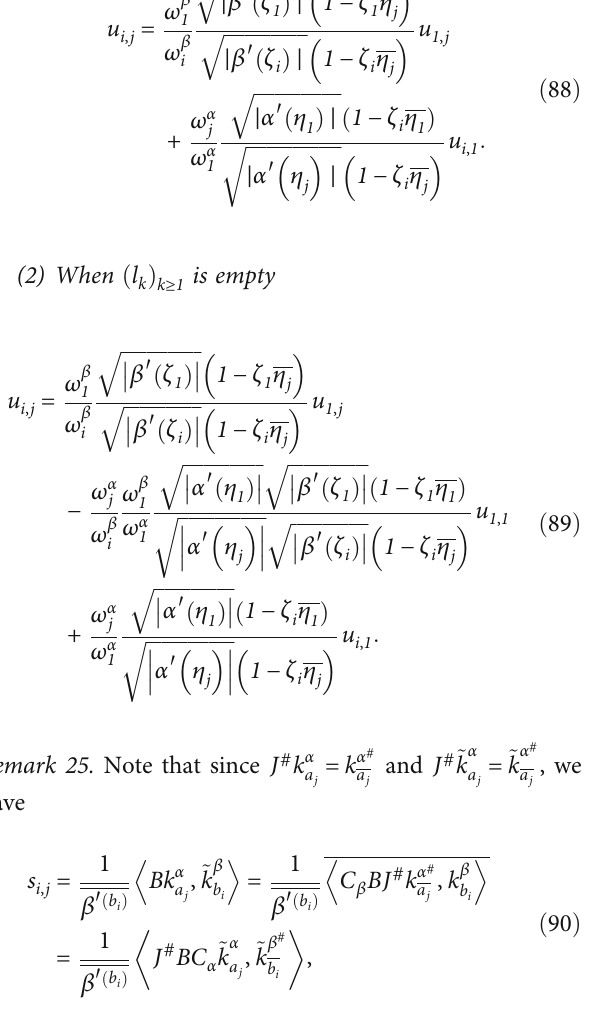
ffiffiffiffiffiffiffiffiffiffiffiffiffiffiffiffi (cid:12) β ′ ζ ð Þ (cid:12) 1 ffiffiffiffiffiffiffiffiffiffiffiffiffiffiffi (cid:12) β ′ ζ ð Þ (cid:12) i